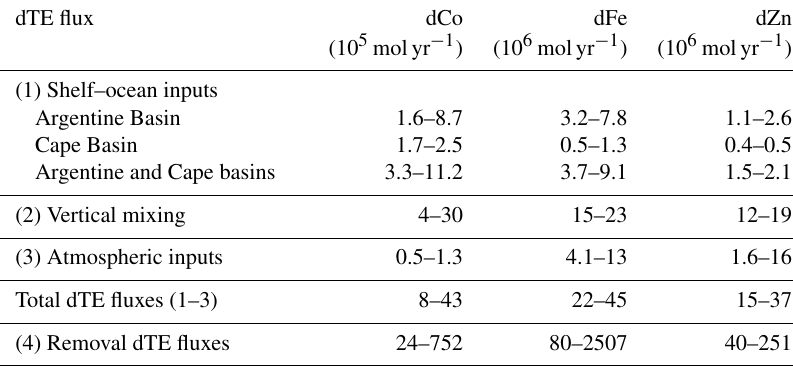
Figure 8. Schematic diagram of dissolved trace element inputs and outputs in the high-productivity zone in the open ocean along the surface 40 ◦ S Atlantic transect. The approximate dimensions of the high-productivity zone and continental shelves are labelled, assuming that the zone spans across the latitude from 35 to 45 ◦ S ( ∼ 1110km) and the longitude from 55 ◦ W to 20 ◦ E ( ∼ 6375km) with a removal flux integration depth of 100m. The arrows indicate different TE inputs and outputs in this region. The TE fluxes from Table 4 are shown and colour coded according to the sources. The vertical red cross sections are used to normalise the shelf–ocean TE and 228 Ra fluxes. The net shelf–ocean TE fluxes represent the total inputs from rivers, SGD, and shelf sediments, and the outputs by particle or biological removal between the shelf–ocean mixing from both sides of the continental margins. The blue surface area is used to estimate the net TE inputs from dust and vertical mixing, and the red cross section above the mixed layer is used to estimate the net shelf–ocean TE fluxes (Table 4). Table 4. Net dTE fluxes in the 40 ◦ S Atlantic open-ocean high-productivity zone ∗ . dTE